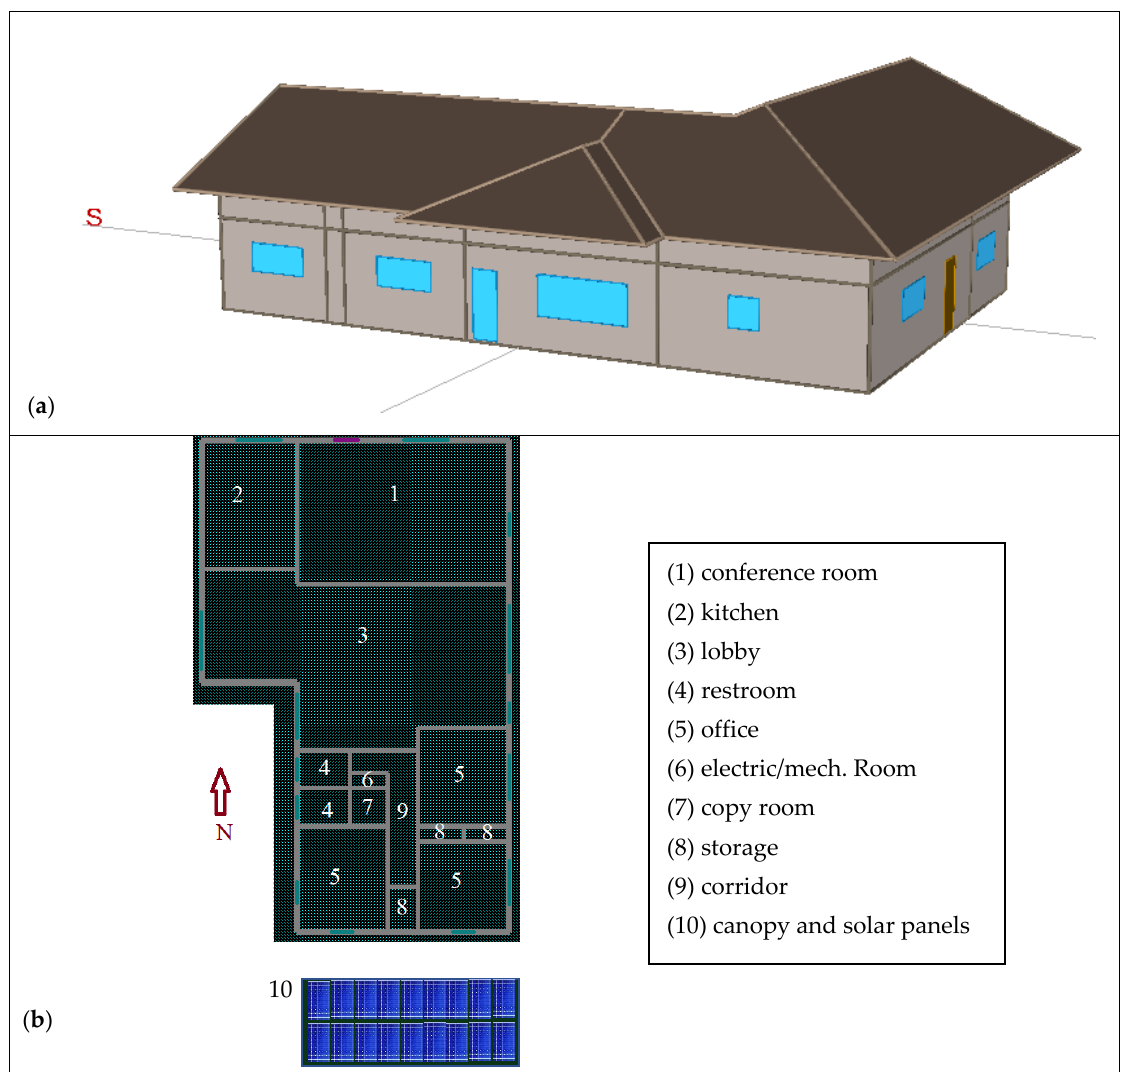
Figure 2. ( a ) 3D building model developed in eQuest; ( b ) building layout.